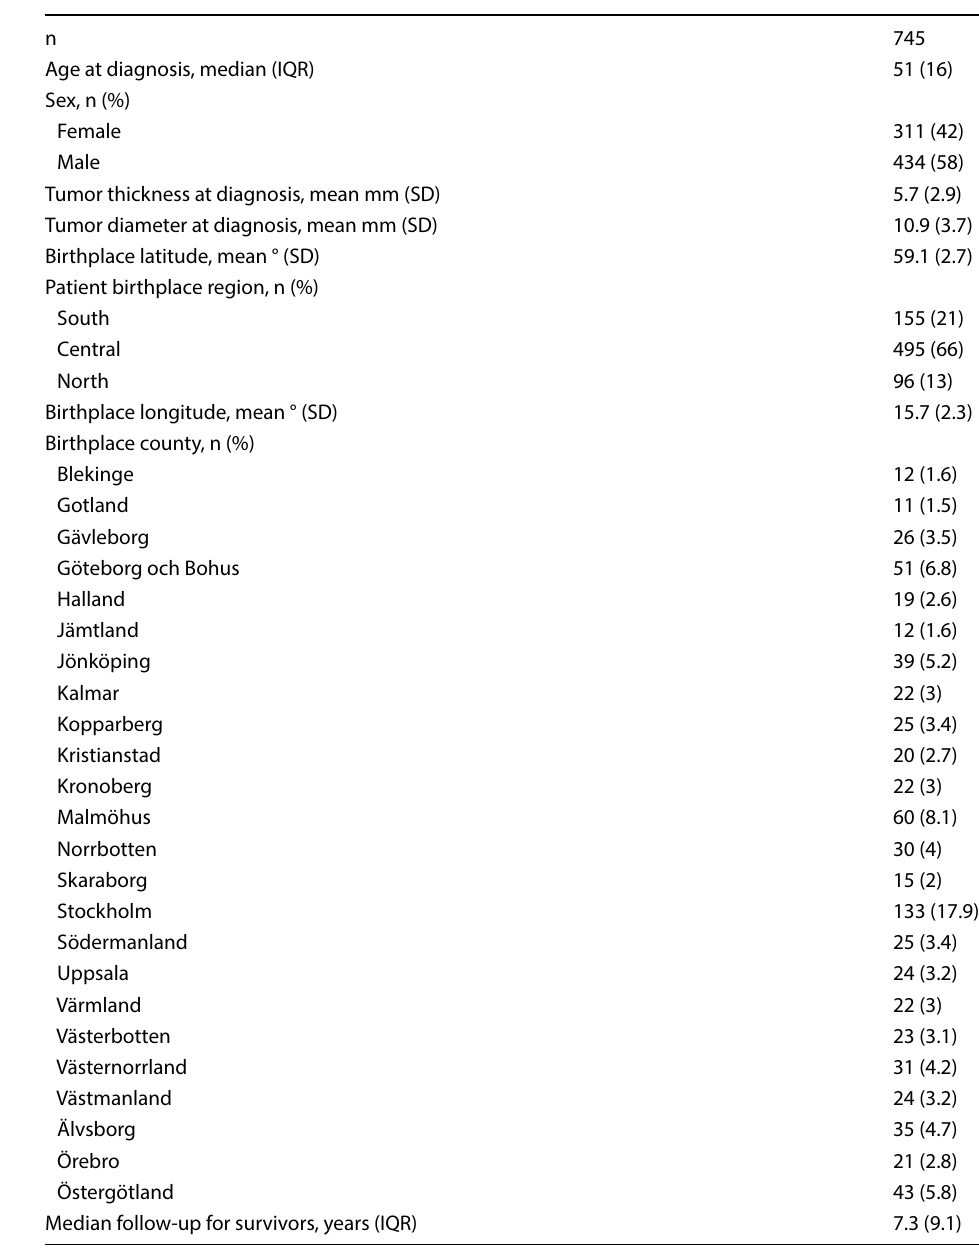
Table 1 Demographics and clinical features of study